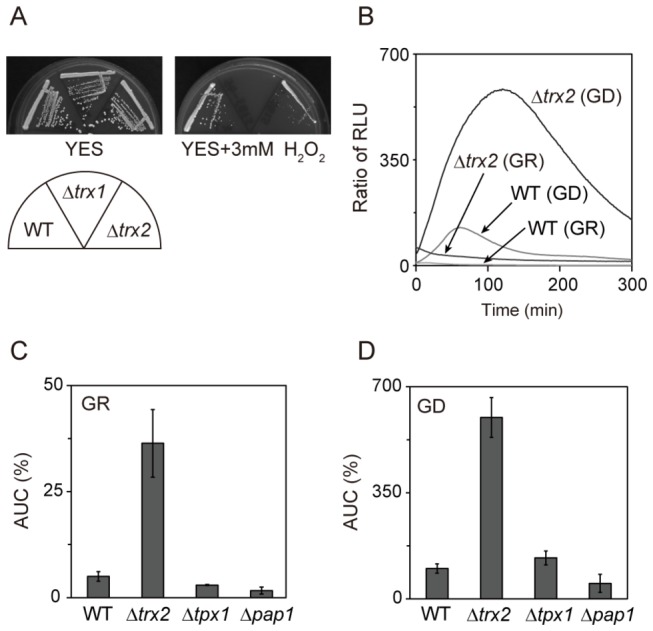
Deletion of the trx2+ gene enhanced Rst2 transcriptional activity.(A) The Δtrx1 and Δtrx2 cells showed H2O2-sensitive phenotype. Wild-type, Δtrx1 and Δtrx2 cells were streaked onto YES plates with or without 3 mM H2O2, and cultured at 30°C for 3 days. (B) Deletion of the trx2+ gene enhanced Rst2 transcriptional activity. Wild-type and Δtrx2 cells harboring the reporter plasmid were cultured and assayed as described in Figure 1A. (C and D) Deletion of the trx2+ gene specifically enhanced Rst2 transcriptional activity. Wild-type, Δtrx2, Δtpx1 and Δpap1 cells harboring the reporter plasmid were cultured and assayed as described in Figure 1A. Error bars, mean ± S.D. (n ≥ 3).